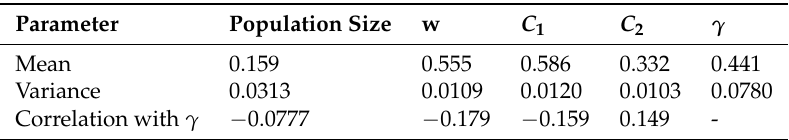
Table A5. Mean and variance values for PSO’s numerical parameters and correlation with a useless one ( γ ). Parameter values are normalized between 0 and